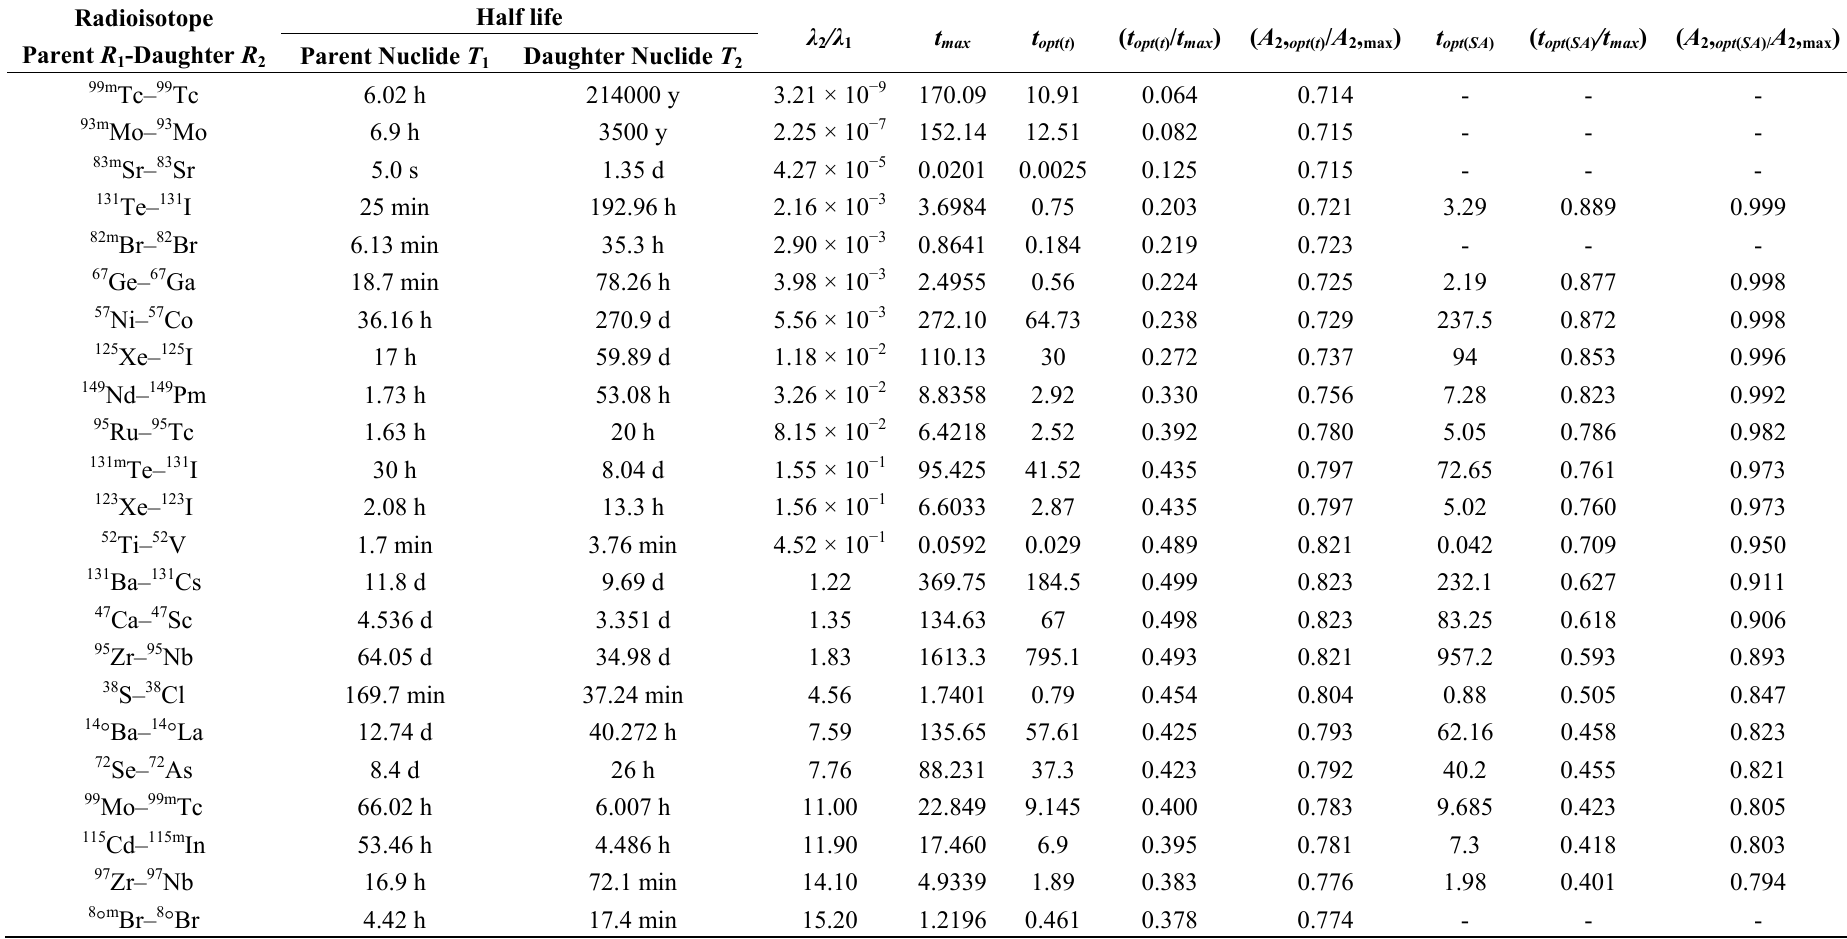
Table 1. Optimal build-up time and radioactivity of daughter nuclide in different radionuclide generator systems: t calculated using Equations (2), (11) and (14), respectively. A , t , and t , respectively, which are calculated using Equation (1) and relevant build-up time values. The half-life time data are from t max opt ( t ) opt ( SA ) References